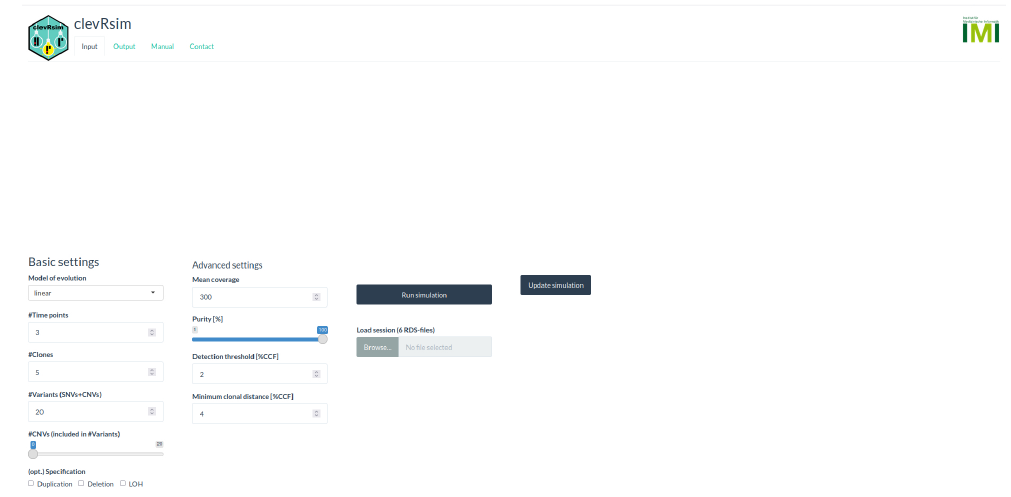
Figure A1. Defining input for the analysis using clevRsim. Basic and advanced settings can be configured for the simulation. Alternatively, a previously exported simulation can be loaded using RDS files.